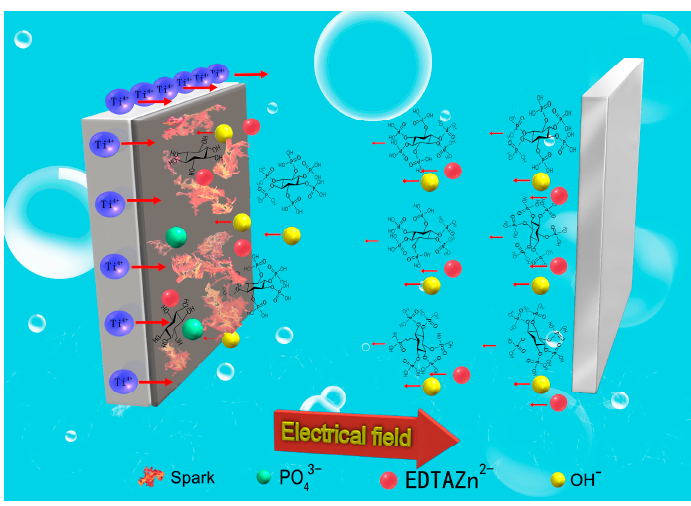
Figure 8. The schematic diagram showing the coating formation during MAO treatment.